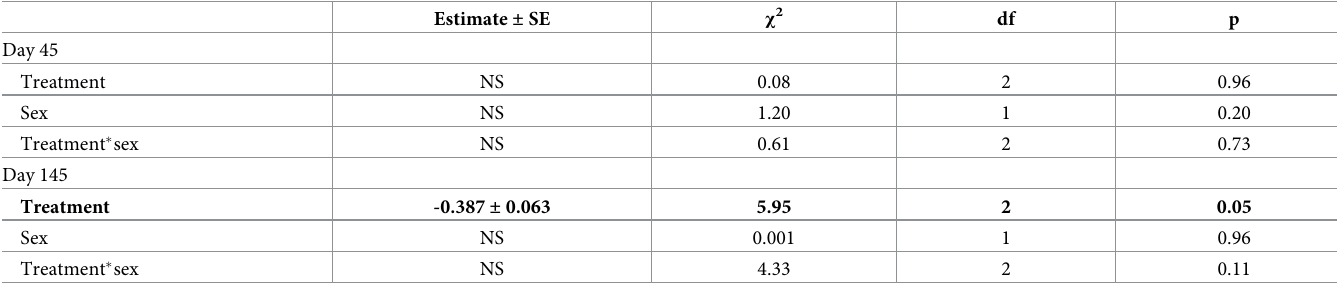
(Table 3, Fig 1). Previous experimental work on e.g. tree swallows and wood ducks have shown that chicks from eggs incubated at lower than normal temperatures hatch with a body mass indistinguishable to that of controls, but show reduced growth patterns of body mass during the nestling period [19, 22]. Such long-term effects on adult body mass have also been reported in Japanese quails, where individuals from eggs incubated at a low temperature (36.0˚C) where lighter than control birds (incubated at 37.5˚C) at 55 days of age [51]. In con- trast, Nord and Nilsson [20] found no effect of incubation temperature (eight days at either Table 4. Results of linear mixed effects models on plasma oxidative status (concentration of ROMs) at 45 and 145 days of